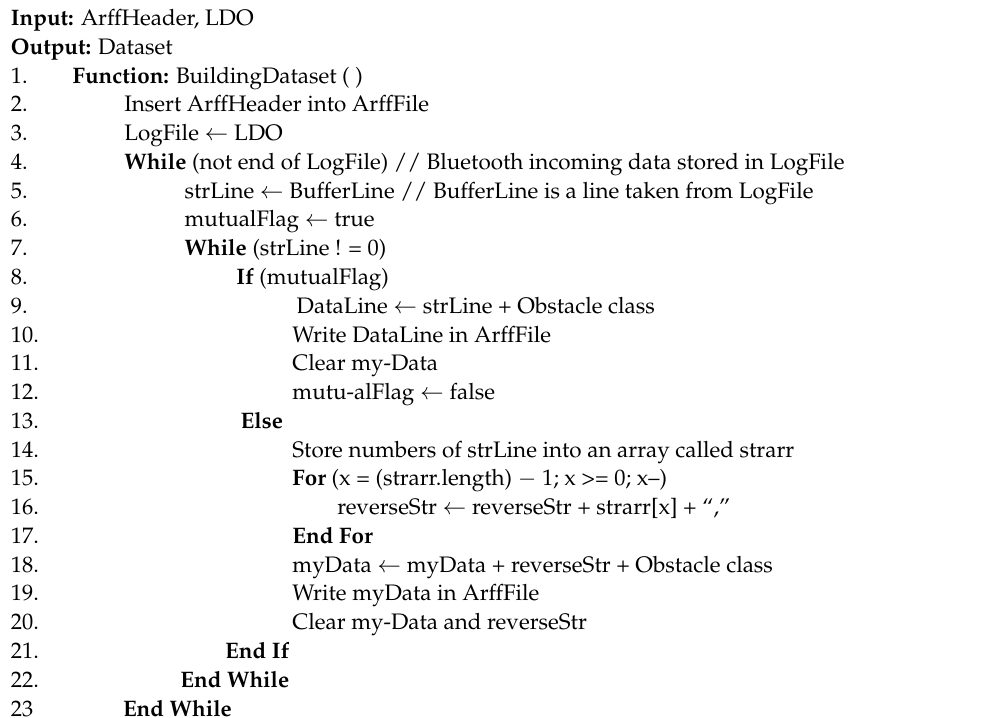
Algorithm 3 : Dataset Module: Building Dataset